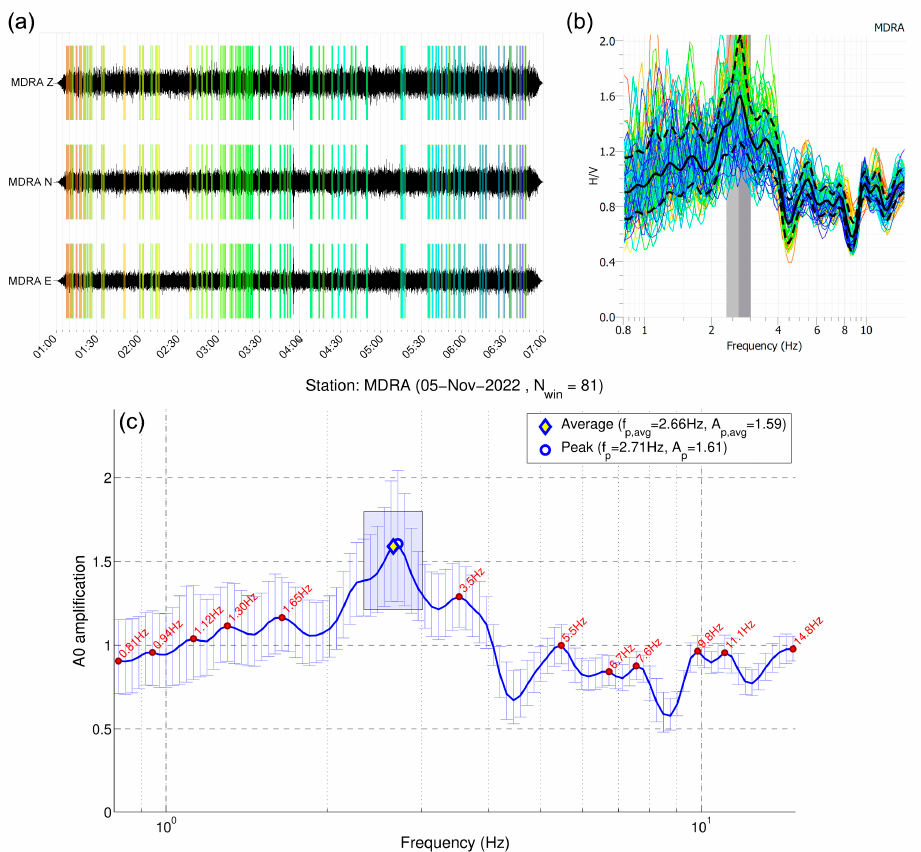
Figure 2. Example from the construction of HVSR curves, for the recordings of station MDRA on 5 November 2022. ( a ) Selection of 81 windows of 60 s length each (vertical colored rectangles) from 6 h continuous records using STA/LTA anti-trigger criteria; ( b ) individual HVSR spectra, with the color of each line corresponding to the colors of the respective windows in panel ( a ), average spectra (solid black line), and respective errors (dashed black lines). The vertical light and dark gray bands indicate the frequency bands corresponding to the dominant peak frequency, f p ; ( c ) a simplified figure of the average HVSR curve (bold blue line), including error bars for each frequency (vertical thin blue lines). The semi-transparent rectangle corresponds to the frequency range depicted by the light and dark gray vertical bands in panel ( b ), with its height corresponding to the average minimum and maximum amplifications for this specific frequency range, with the average frequency depicted by a yellow (with blue outline) diamond symbol. The blue circle indicates the global peak frequency of the average HVSR spectrum. The red circles mark the local maxima of the HVSR curve, corresponding to secondary peaks, with the frequencies labeled with red